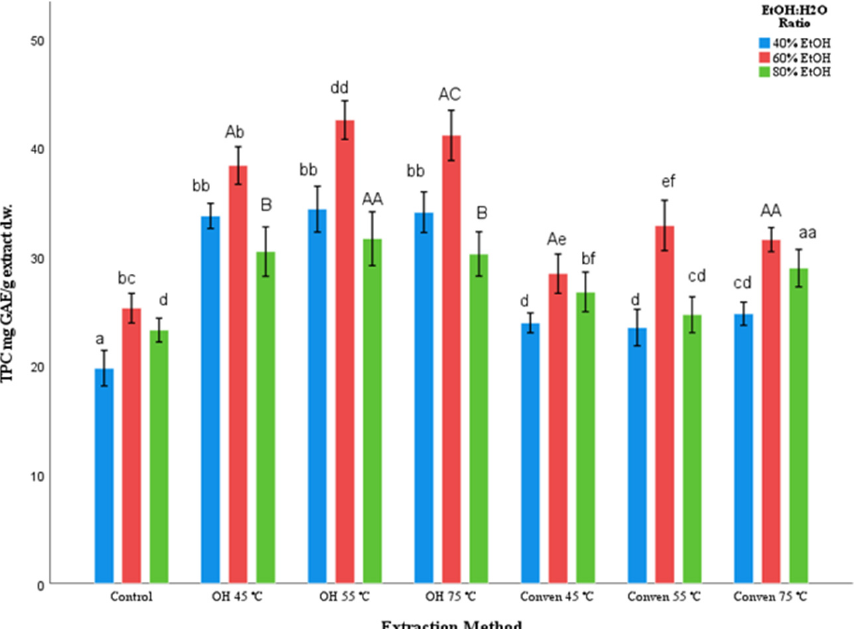
Figure 4. Total phenolic content (TPC) mg GAE/g extract d.w. through various extraction methods are presented with standard deviation bars. The Control represents the extraction with no heat treatment (25 °C). The OH represents ohmic extraction using different concentrations of aqueous ethanol (40%, 60%, and 80% EtOH v / v ) and different temperatures (45 °C, 55 °C, and 75 °C). The Conven represents groups of samples with conventional heating using the same solvent ratios/temperatures as those applied for ohmic system. Different letters (a–f, A–C) above the bars indicate statistically significant differences between means ( p < 0.05).